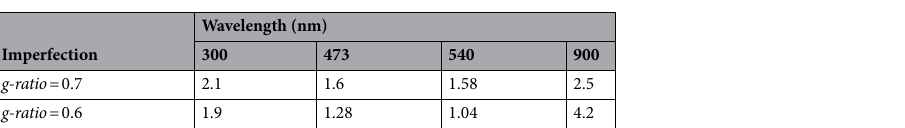
Figure 5. Light transmission spectra for different g-ratios at output of the ( a ) myelin sheath and ( b ) axon, when light is launched to the myelin sheath.